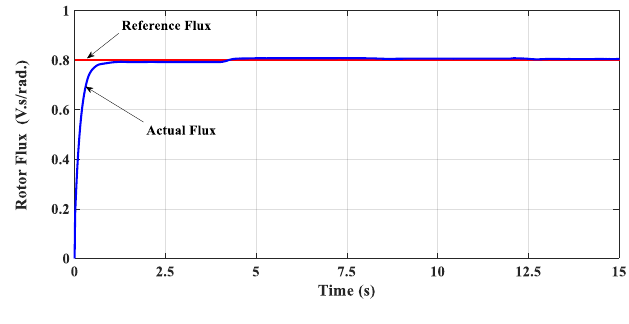
Figure 11. Response of the rotor flux.